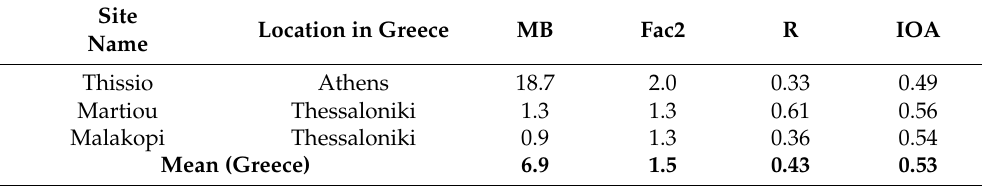
Table 7. Statistical metrics for SO 2 mean daily concentrations ( µ g/m 3 ) for each monitoring site over Thessaloniki, Greece (for d03 domain, 2 × 2 km 2 ) and the rest of Greece (for d02 domain, 6 × 6 km 2